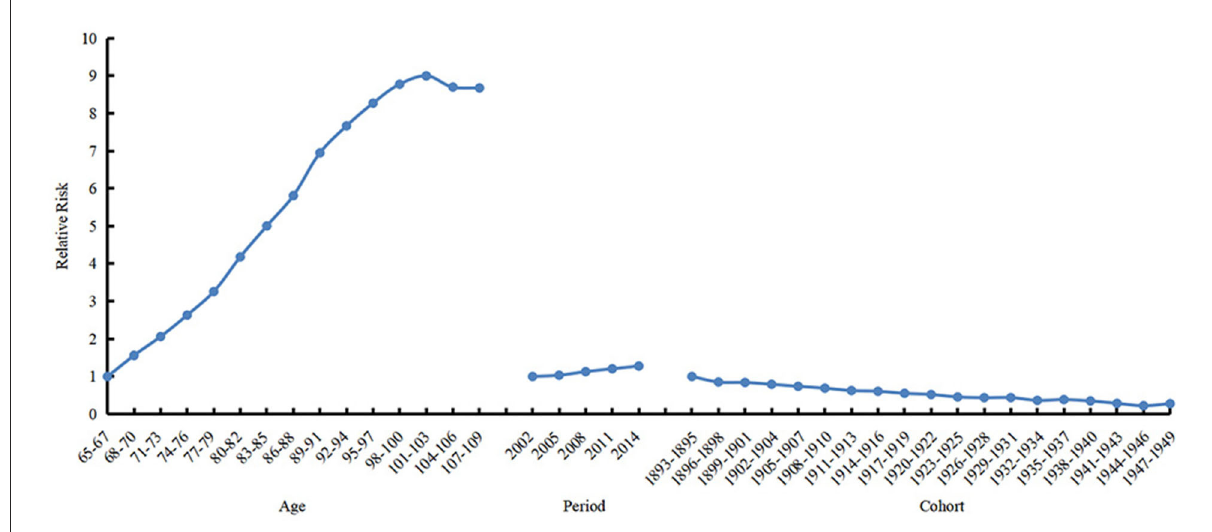
FIGURE4 Relative risks of age (left), period (mid) and cohort (right) effects on prevalence of